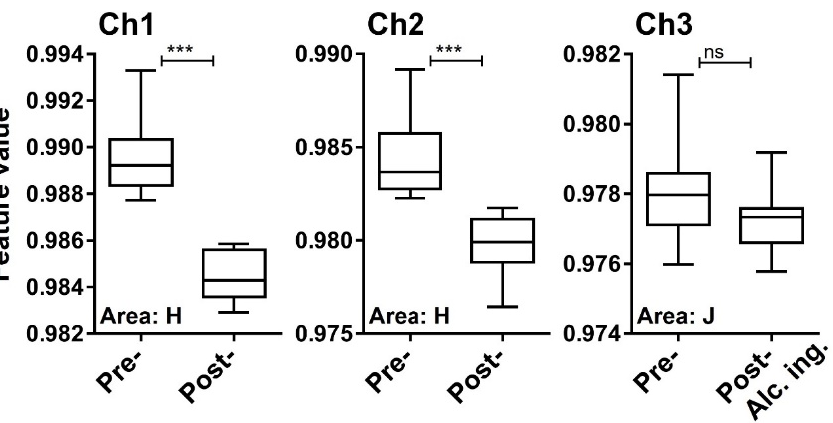
Figure 9. Feature values of pre- and post-alcohol ingestion breath samples processed by the min-max normalization method. Box plots represent the statistical differences evaluated by the two-tailed Mann-Whitney U test (***, p < 0.0001; ns, not significant).